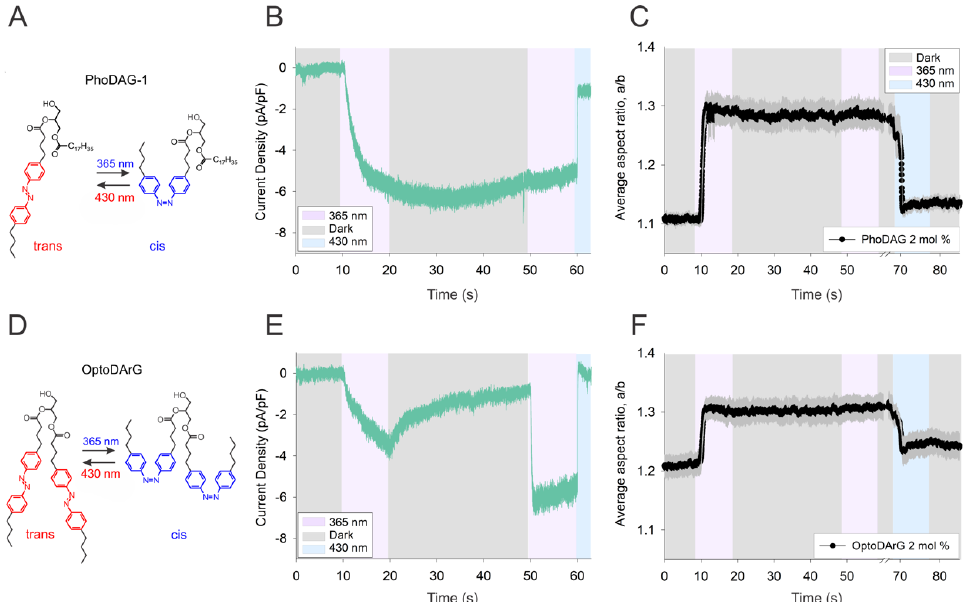
Figure 2. Comparison of the kinetics of thermal relaxation of photochromic diacylglycerols. ( A , D ) Chemical structures of photochromic diacylglycerols: ( A ) PhoDAG − 1; ( D ) OptoDArG. ( B , E ) Representative traces showing the inward currents induced by photoactivation of PhoDAG − 1 (( B ), 100 μM) and OptoDArG (( E ), 20 μM) in a whole − cell gap −free recording (holding potential: −40 mV, baseline adjusted to 0 mV, normalized by capacitance) in TRPC3 − WT − expressing HEK293 cells. To photoconvert OptoDArG, we used 100% intensity of UV (365 nm; violet) for 10 s to switch to active ( cis state), followed by the dark (UV illumination off) for 30 s (grey) and then blue light (430 nm) for 3 s (blue). ( C , F ) GUV shape deformation (presented in terms of the a/b aspect ratio) due to photoisomerization of ( C ) PhoDAG − 1 and ( F ) OptoDArG, each averaged over nine different vesicles (the standard error of mean is shown in dark gray). The same irradiation protocol as in ( B , F ) was followed.